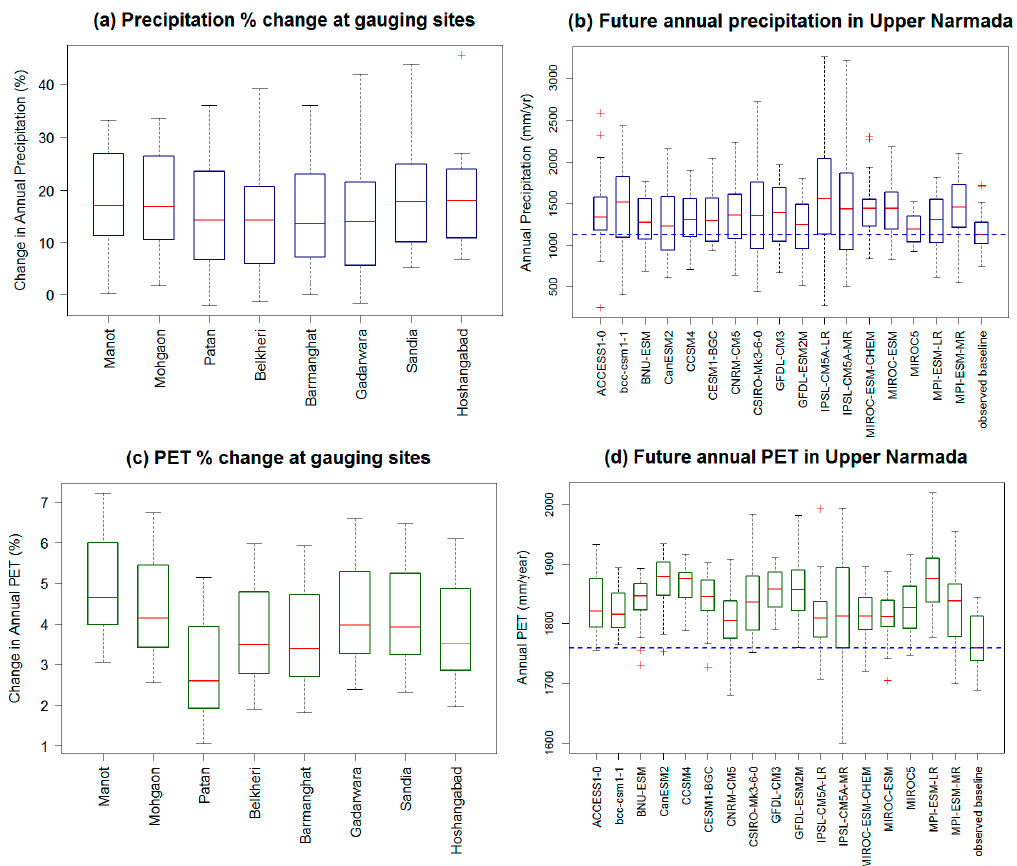
Figure 5. ( a ) Percentage change in total mean precipitation at each gauging site between baseline and future period; ( b ) Annual precipitation in the Upper Narmada for each GCM ( c ) Percentage change in total mean Potential Evapotranspiration (PET) at each gauging site between baseline and future period; ( d ) Annual PET in the Upper Narmada for each GCM. Values more than 1.5 times the interquartile range below the 25th quartile or above the 75th quartile are plotted as outliers (+).